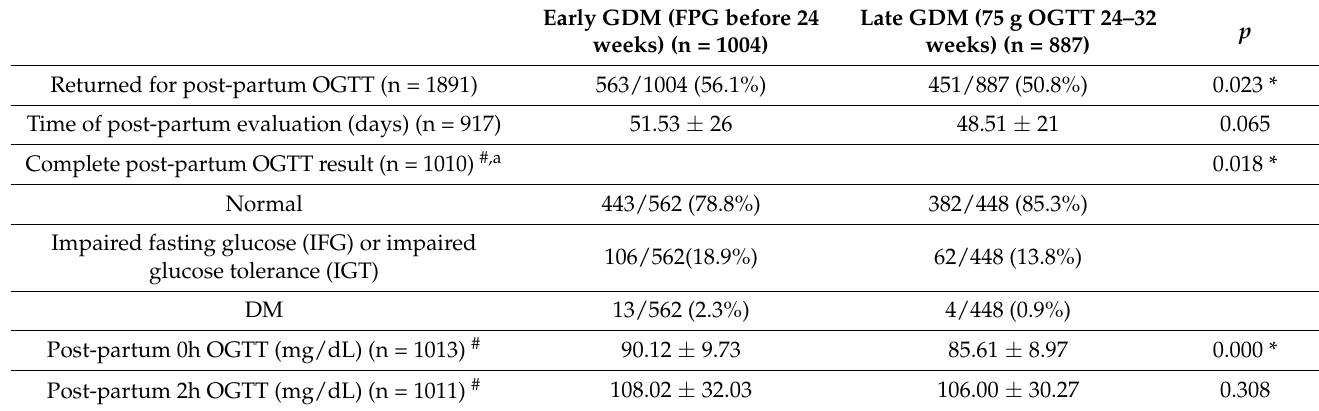
Table 3. Postpartum evaluation of women diagnosed with early or late gestational